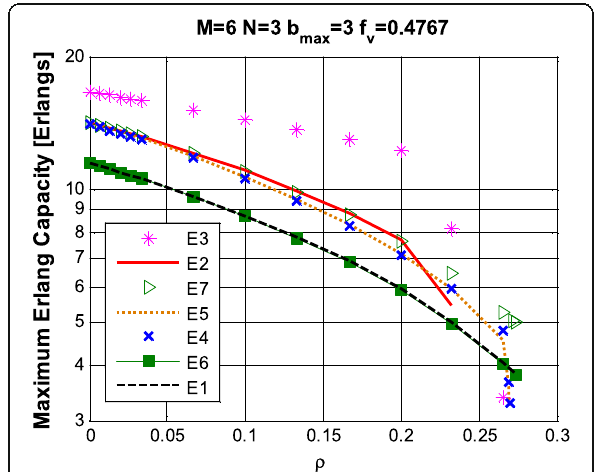
Fig. 6 Maximum Erlang capacity as a function of ρ , for f v =